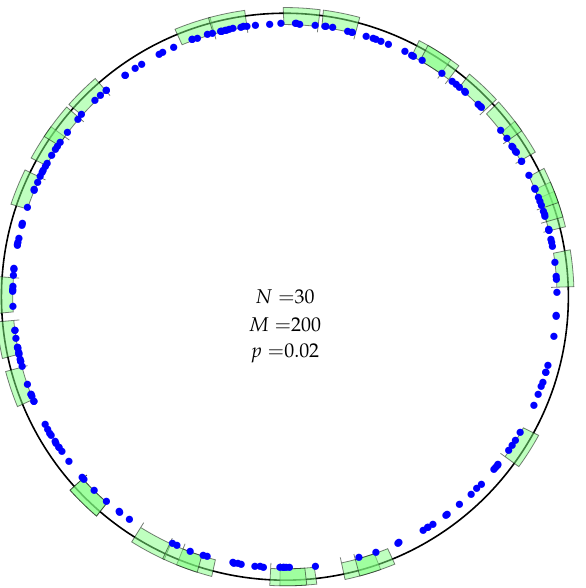
Figure 13. An example of epitope space: the unit circle. Each blue dot is a pMHC complex, M of which are scattered randomly on the circle. Each green arc is the recognition region of a TCR clonotype. We assume each TCR clonotype occupies a fraction p of the unit circle. The centers of the arcs are scattered randomly on the circle. Arcs may overlap: pMHCs in the overlap region are recognized by all the TCRs defined by those